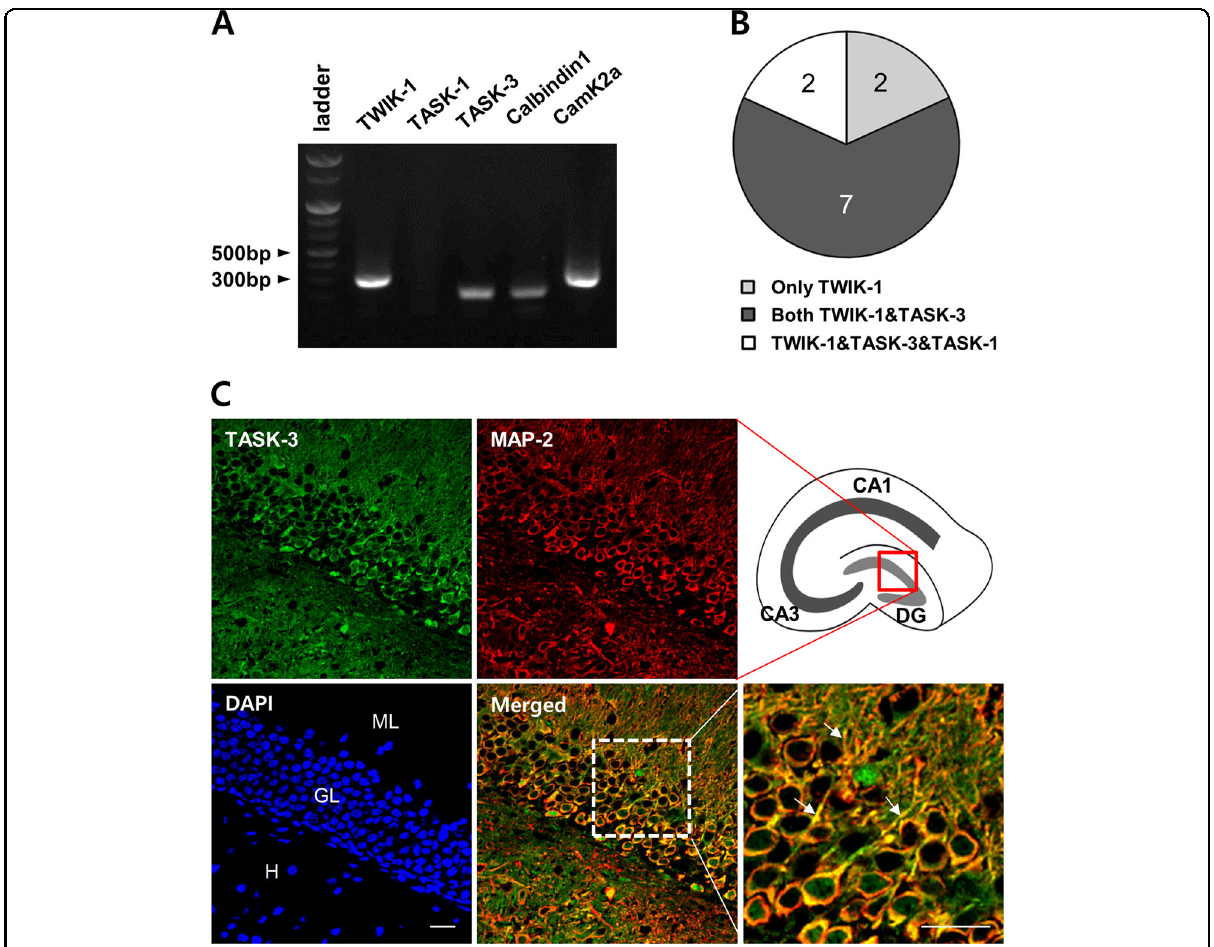
Fig. 1 TWIK-1 and TASK-3 are coexpressed in mouse hippocampal DGGCs. a Representative electrophoresis image of single-cell RT-PCR showing the expression of TWIK-1, TASK-1, TASK-3, Camk2 α , and Calbindin1 in single DGGC. b A pie chart showing proportion of TWIK-1, TASK-1, and TASK-3 expression in the DGGCs. c Representative fl uorescence images of the dual immunostaining of TASK-3 (green) and MAP-2 (red), with DAPI staining of the nuclei (blue) of dentate gyrus granule cells in the mouse hippocampus. The images show that TASK-3 was highly expressed in the dentate granular cell layer. The merged image demonstrates that TASK-3 was co-localized with MAP-2-positive proximal dendrites of granular cells (Magni fi ed image, arrows). Scale bar, 20 μ m. ML molecular layer, GL granule layer, H hilus, CA1 cornu ammonis 1, CA3 cornu ammonis 3, DG dentate